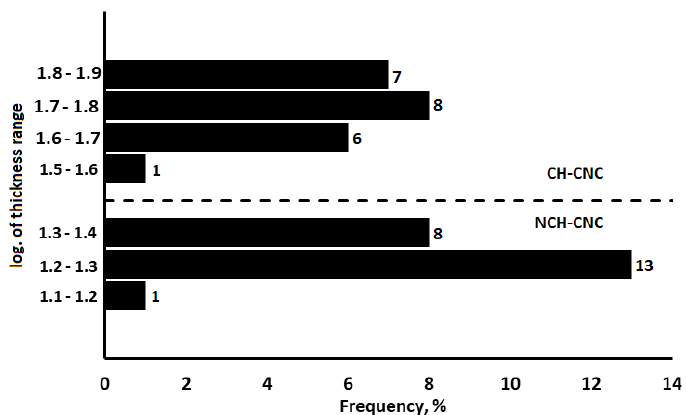
Figure 8. T-test graph of CH-CNC and NCH-CNC film thickness.